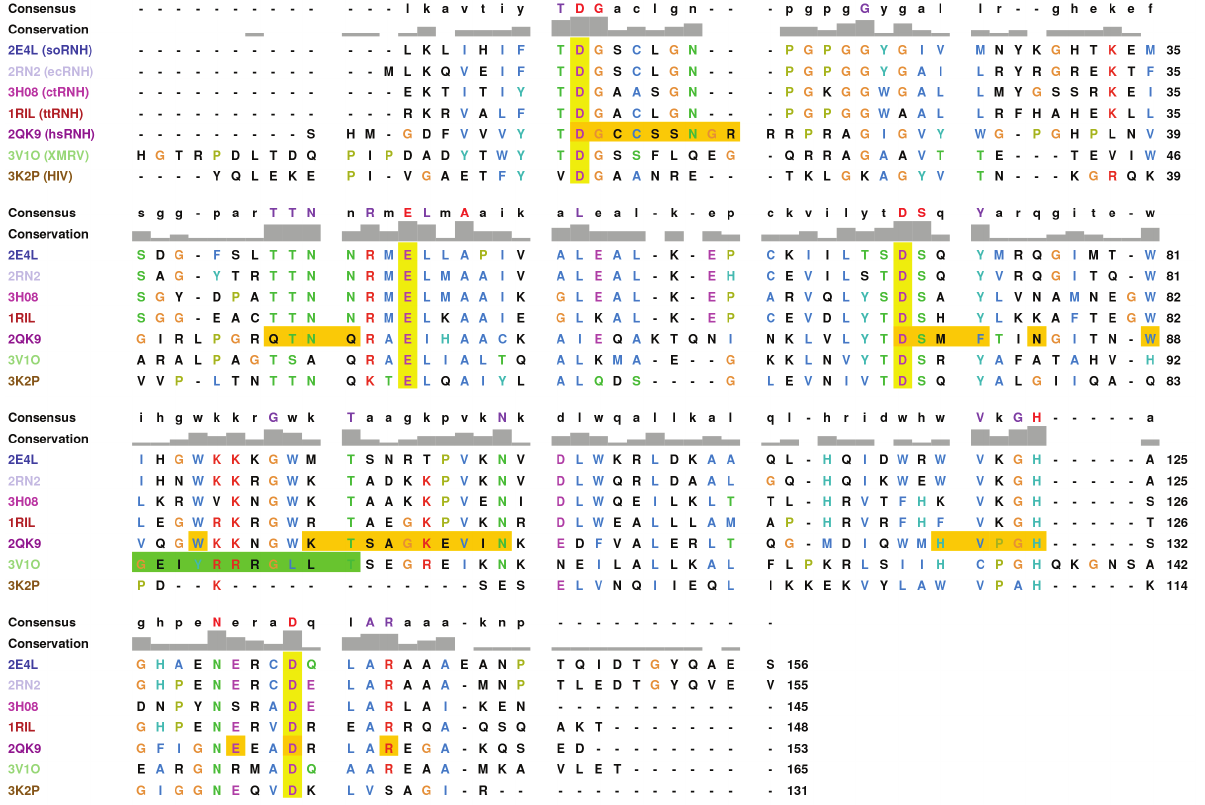
Figure 8. Multiple sequence alignment of RNase H homologs. The Promals3D 46 structural alignment of the PDB structures used to initiate simulations (see Table 1) is shown with active-site residues highlighted in yellow. Residues that form contacts with substrate in the hsRNH complex (PDB ID 2QK9) are highlighted in orange. The ∆ C deletion of XMRV is shown in green. The catalytically inactivating D70N mutation in 2QK9 has been reversed and missing residues from the ctRNH structure (PDB ID 3H08) have been filled in for clarity. Residues are numbered relative to ecRNH. Figure prepared with UCSF Chimera 47